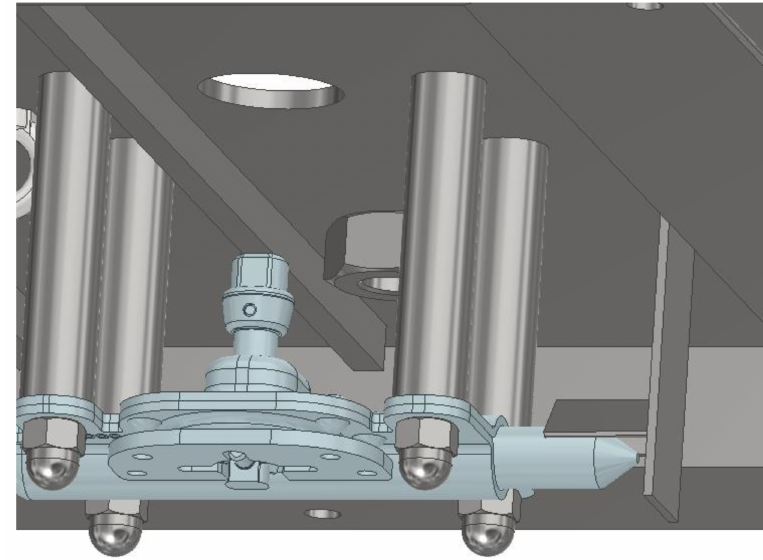
Figure 3. Locking system of the